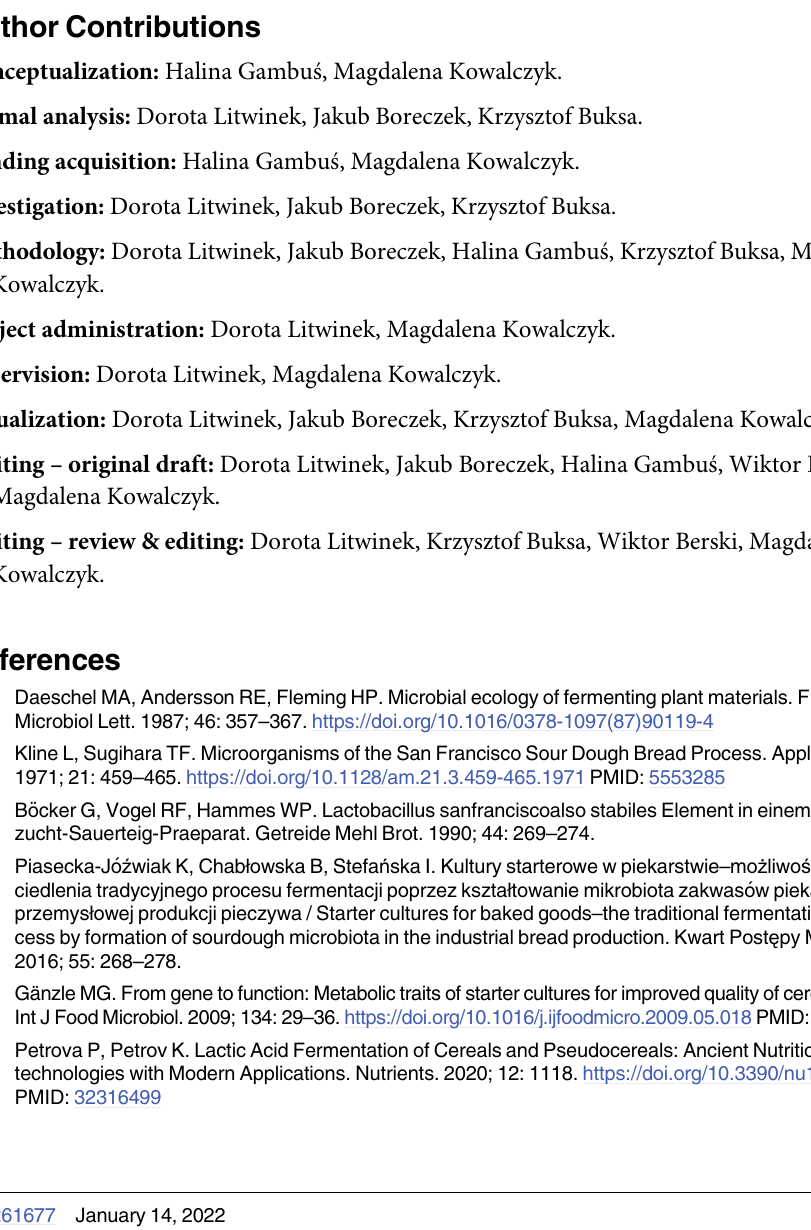
S1 Table. API 50 CHL results of the lactic acid bacteria (LAB) excluding Enterococcus strains, isolated from the rye wholegrain sourdoughs. S2 Table. Glucose, maltose, glycerol and ethanol in the investigated breads [%